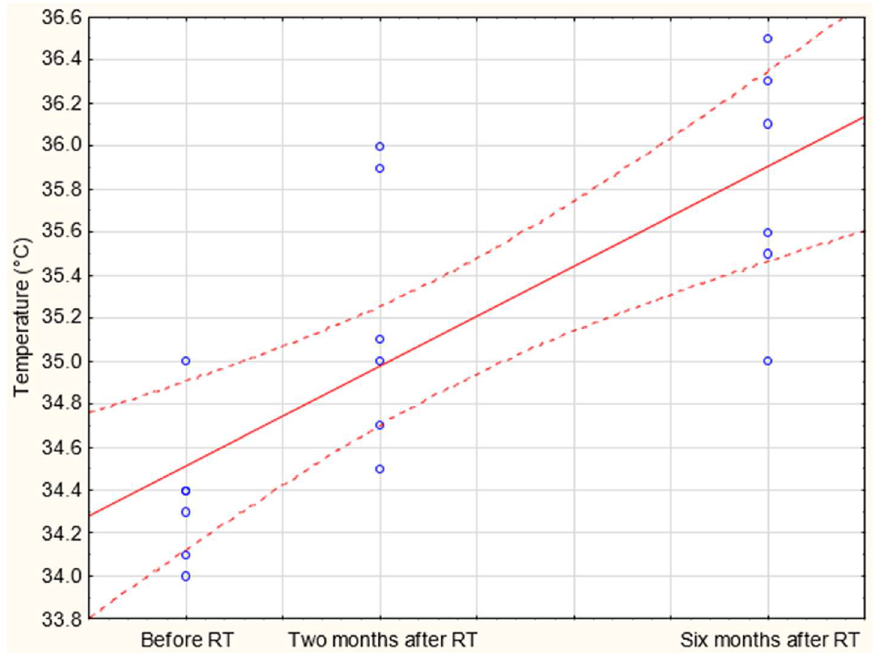
Figure 6. Correlation graph between the temperature values and time after radiotherapy.